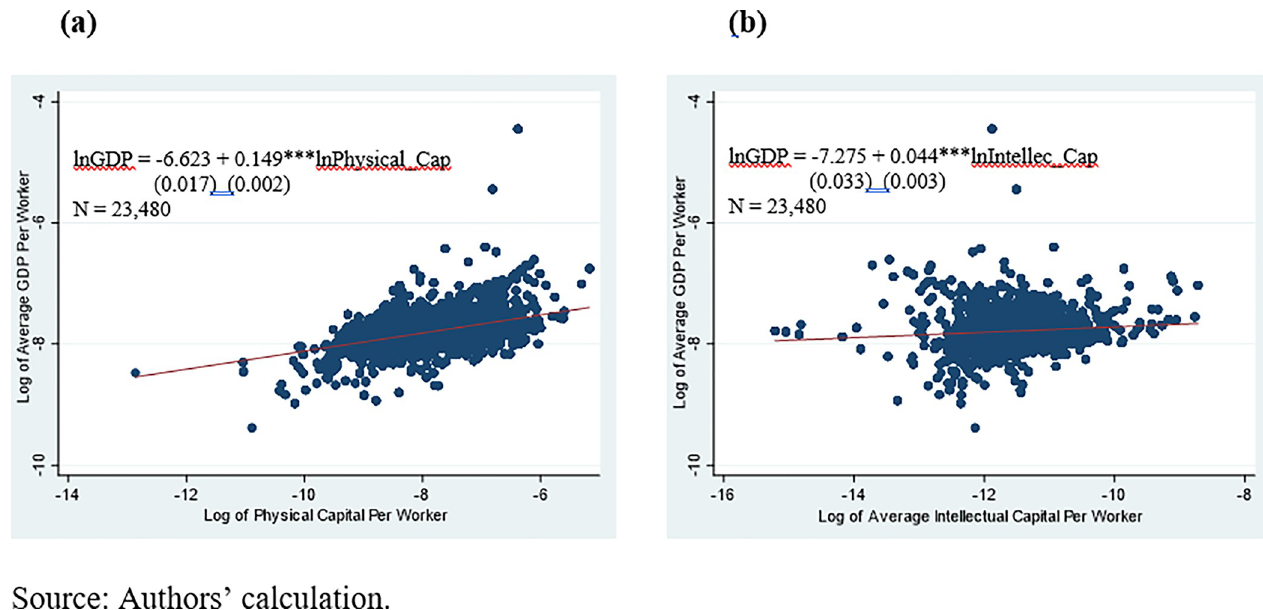
Fig 1. Relationships between productivity and capital investment. (a) Physical Capital and Productivity. (b) Intellectual Capital and Productivity.